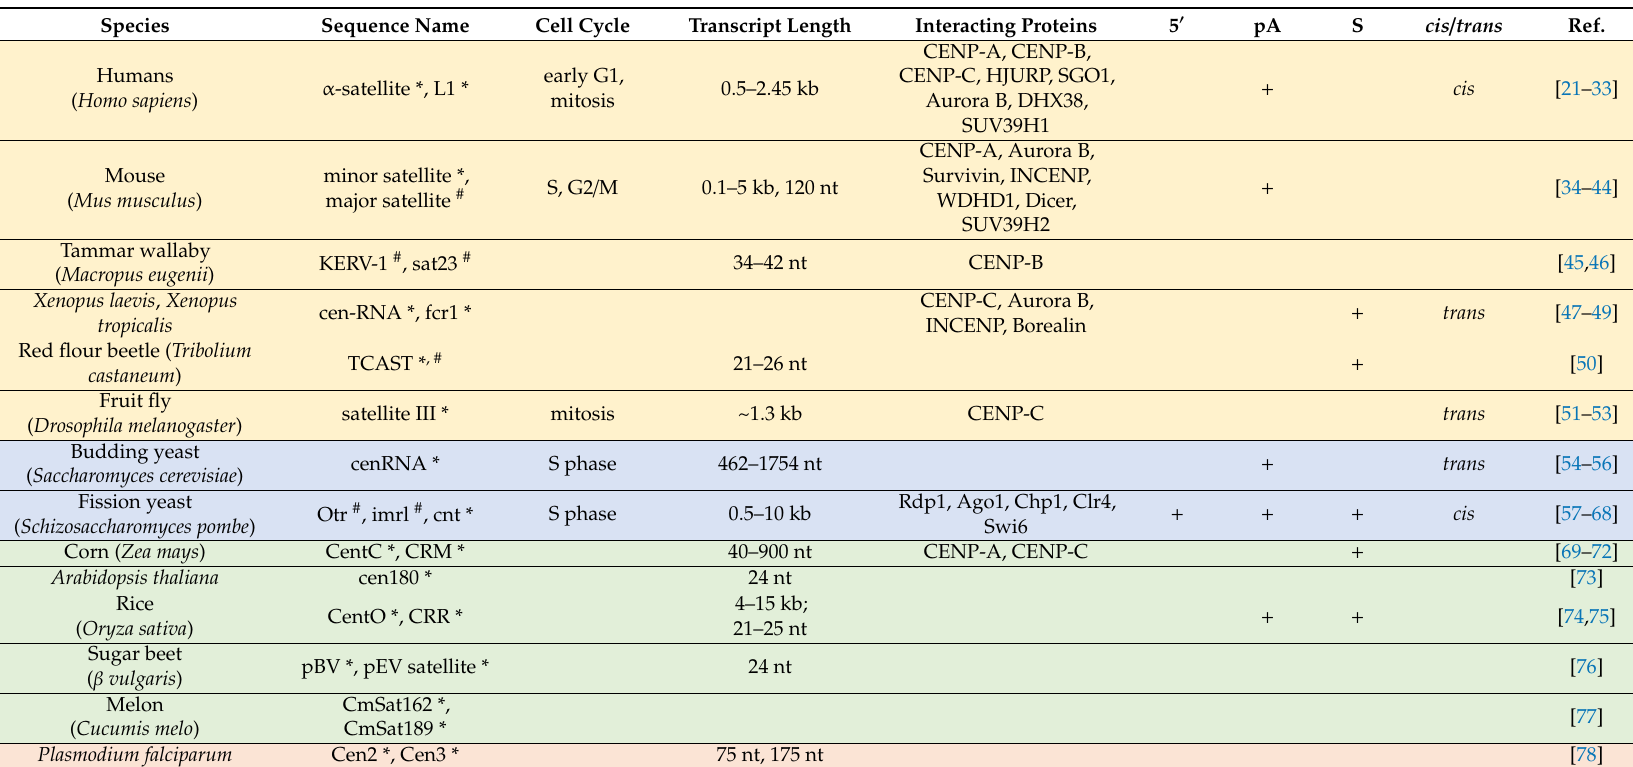
* centromere core region and # pericentromeric region. The yellow, blue, green, and red colors represent the Animalia, Fungi, Plantae, and Chromista kingdoms,